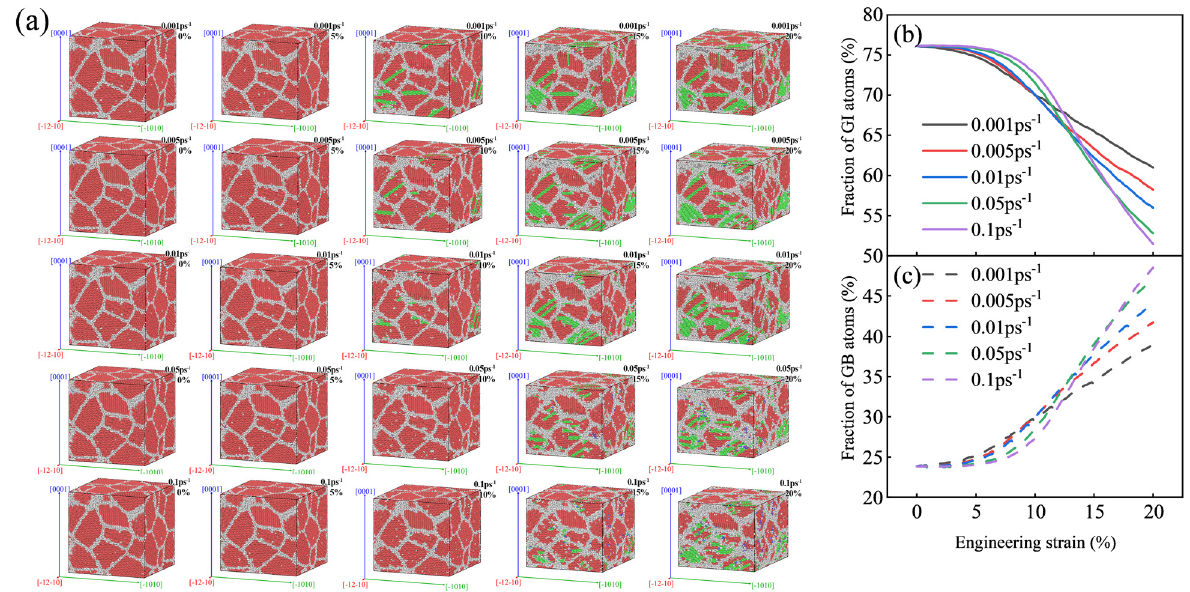
Figure 20: Grain boundary evolution: ( a ) CNA diagram, ( b ) GI atomic curve, and ( c ) GB atomic